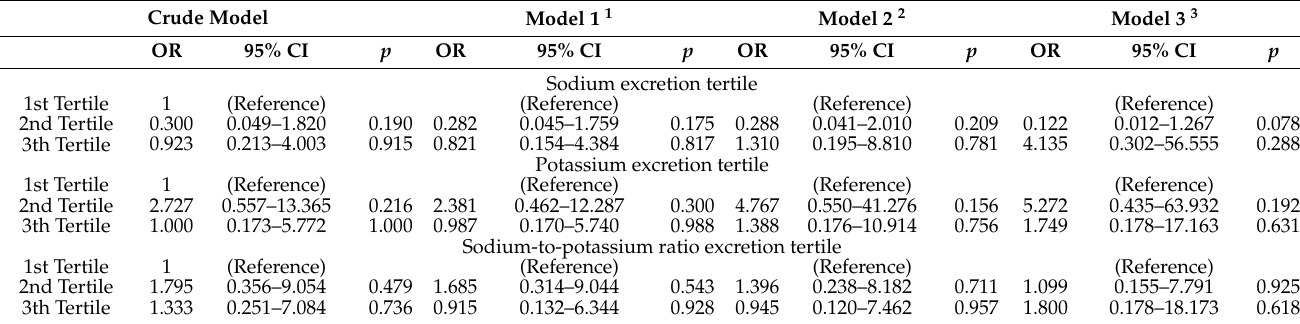
Table 4. Female Odds Ratios for the association between high adherence to MD and sodium, potassium, and sodium-to- potassium ratio last